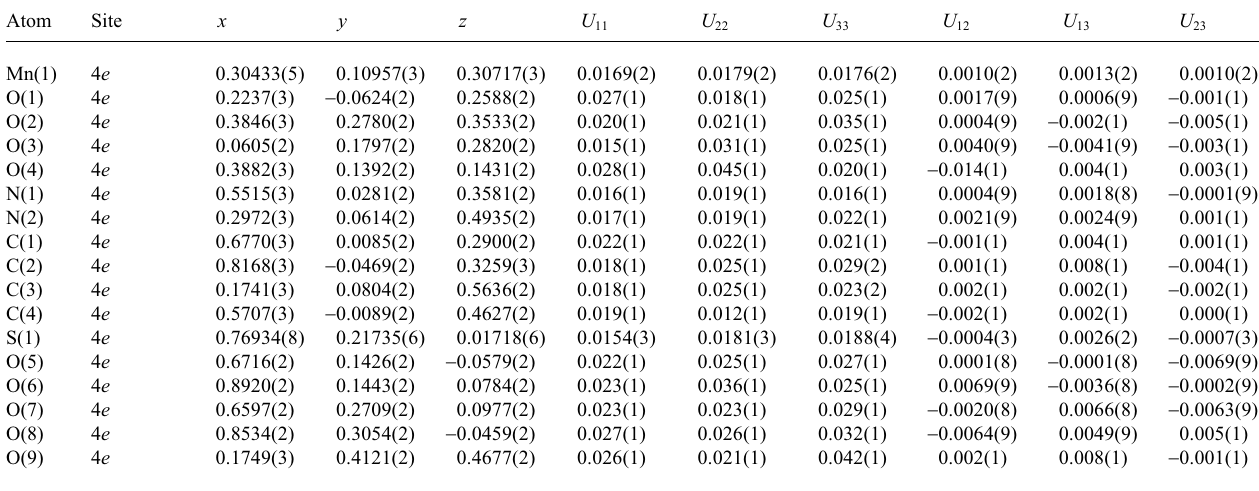
Table 3. Atomic coordinates and displacement parameters (in Å 2 )